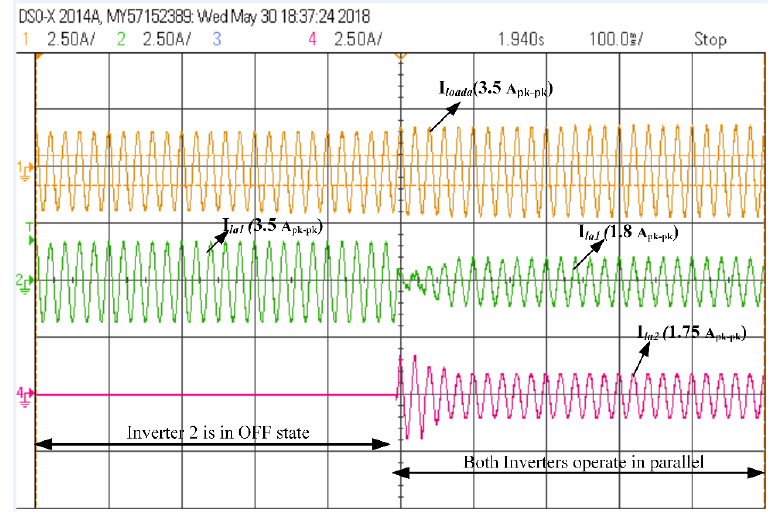
Figure 22. Current sharing during transient operation of parallel inverter.